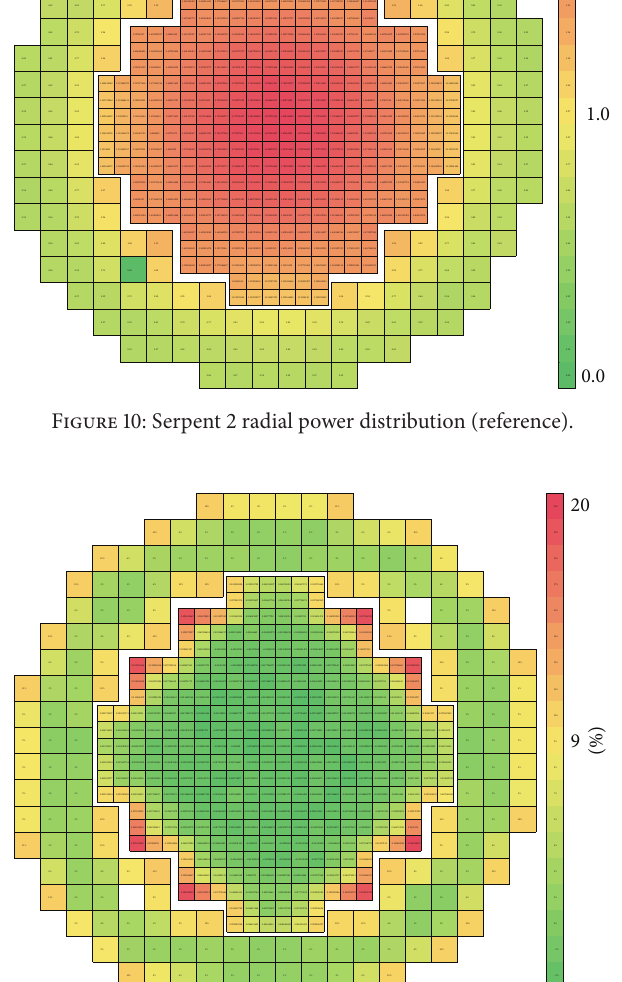
Figure 11: Radial power difference (Serpent 2 versus PARCS).